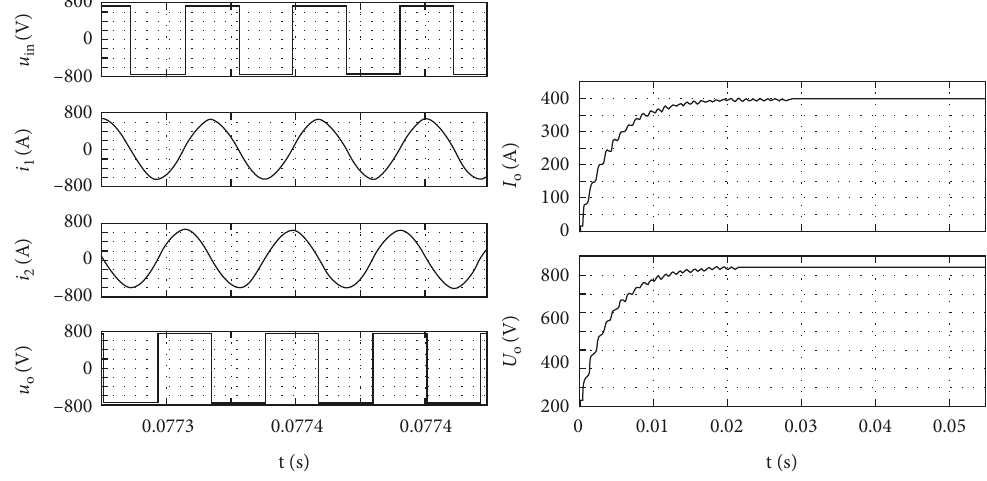
Figure 10: MATLAB simulation results when the air gap is 100mm.